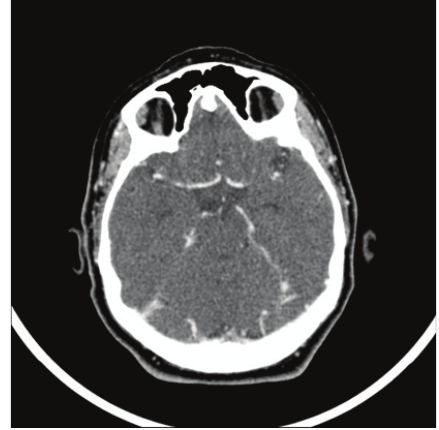
Figure 2: Normal CT